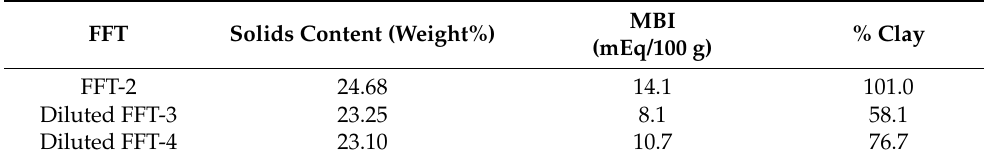
Figure 12. Dosage curves of FFT-2, diluted FFT-3, and diluted FFT-4 treated with polymer A3338: ( a ) NWR results corresponding to solid based polymer dosage; ( b ) CWR of flocs corresponding to clay based dosage; ( c ) water layer index of flocs corresponding to MBI based dosage. Each dot is the average value of duplicate or more testing results. Table 6. The measured MBI value, calculated % clay and CWR results of FFT-2, diluted FFT-3, and diluted